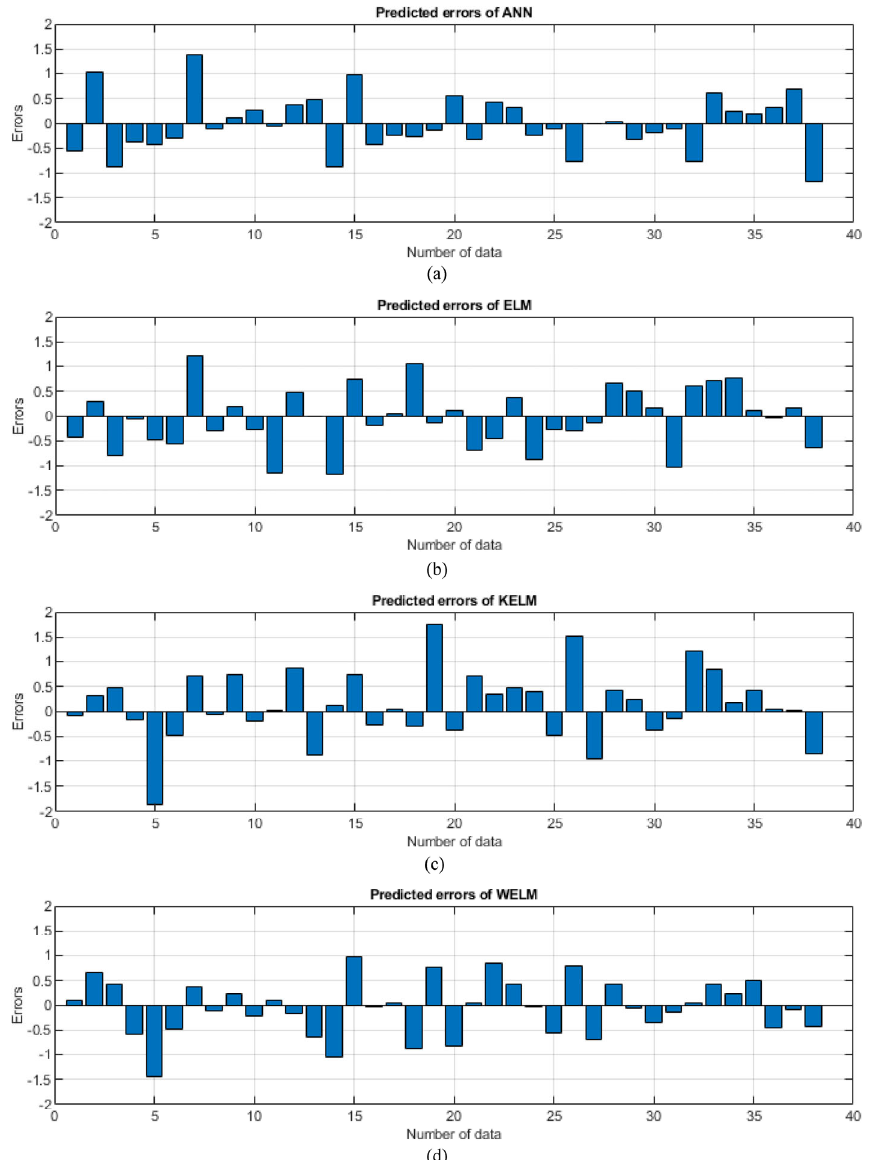
Fig. 7 Error bar graph of models designed with machine learning